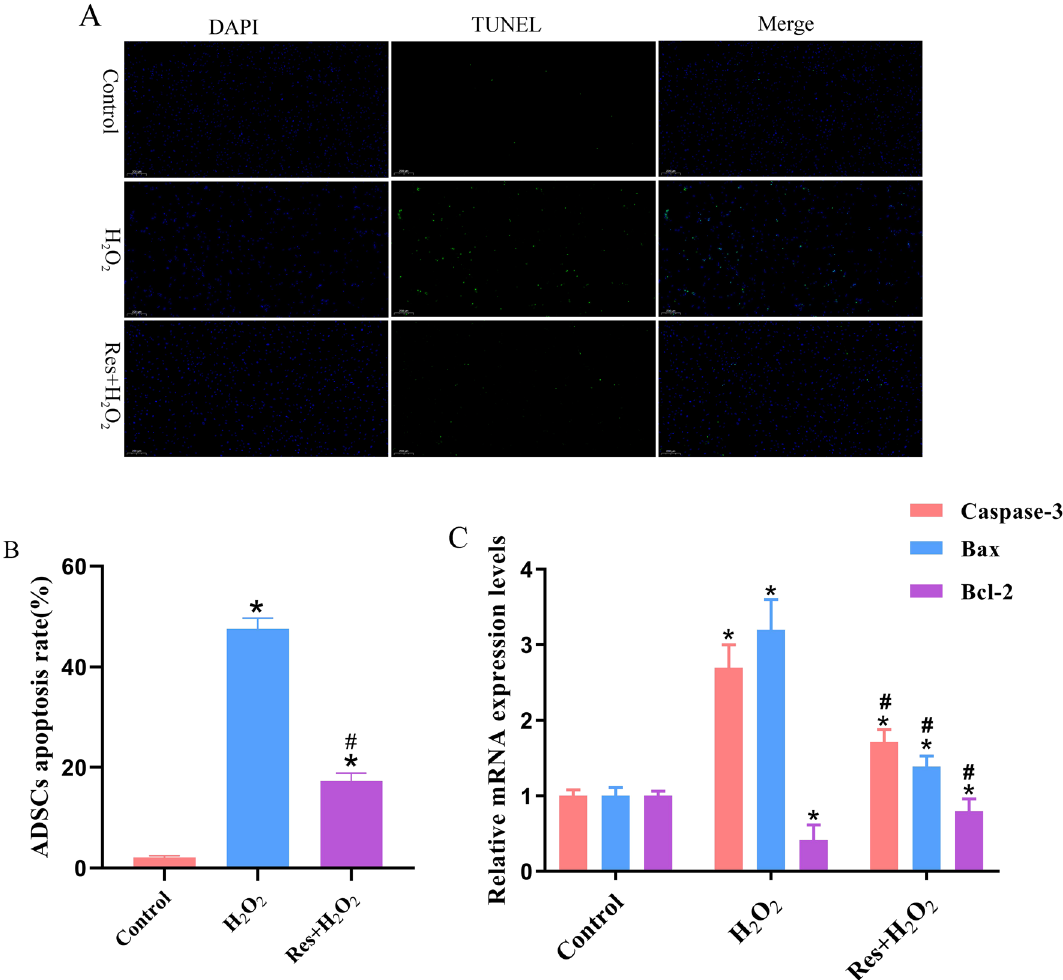
Figure 5. Effects of Res pretreatment on the activity of H 2 O 2 -induced ADSCs. ( A ) TUNEL staining was used to detect the apoptosis rate of ADSCs induced by H 2 O 2 after 24 h Res treatment. ( B ) The apoptosis rate of the ADSCs in ( A ). ( C ) Effects of Res on the expression of mRNA in H 2 O 2 -induced ADSCs. * P < 0.05 compared with the control group, n = 5. # P < 0.05 compared with the H 2 O 2 group, n = 5. Scale bar: 50